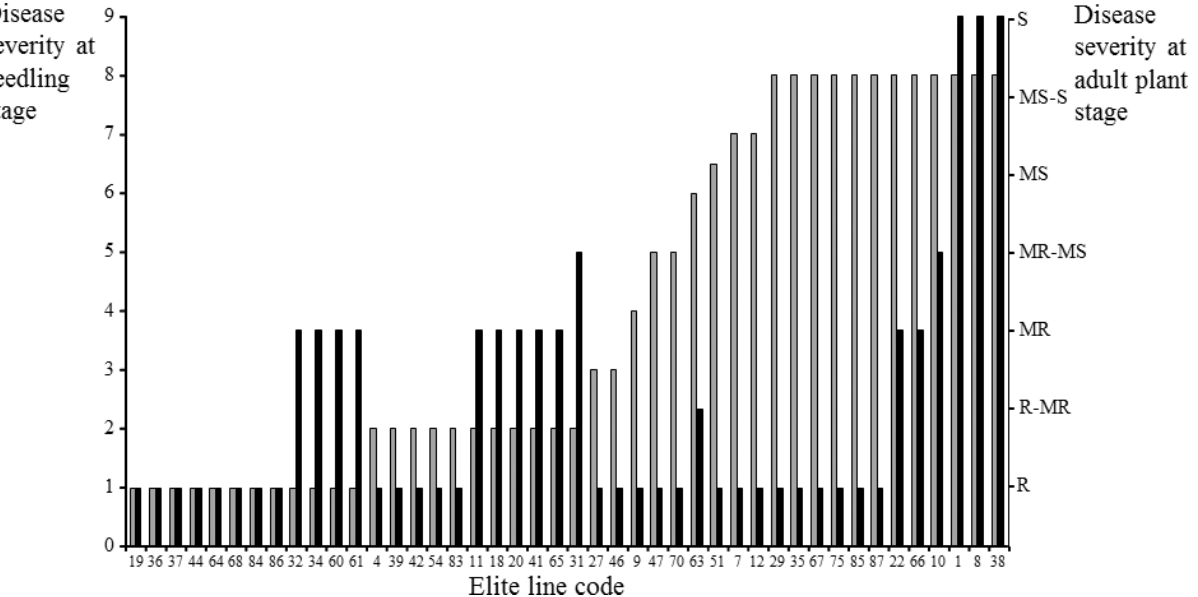
Figure 2. Disease severity at the seedling (gray columns) and adult-plant (black columns) growth stages, for 44 ICARDA bread wheat elite lines inoculated with the predominant pathotype for the 2010-2011 season in Lebanon and Syria. This pathotype carries v2 , 6 , 7 , 8 , 9 , 25 , 27 , and SD , according to the pathotype surveys conducted by ICARDA for the same year. Disease severity at the seedling stage is scored from 0 to 9, where 0 was considered fully resistant and 9 fully susceptible (McNeal et al. 1971). At the adult-plant stage, disease severity was recorded as described by Roelfs et al. (1992); R = resistant, MR = moderately resistant, MS = moderately susceptible, and S = susceptible. The codes of the elite lines are given in Table